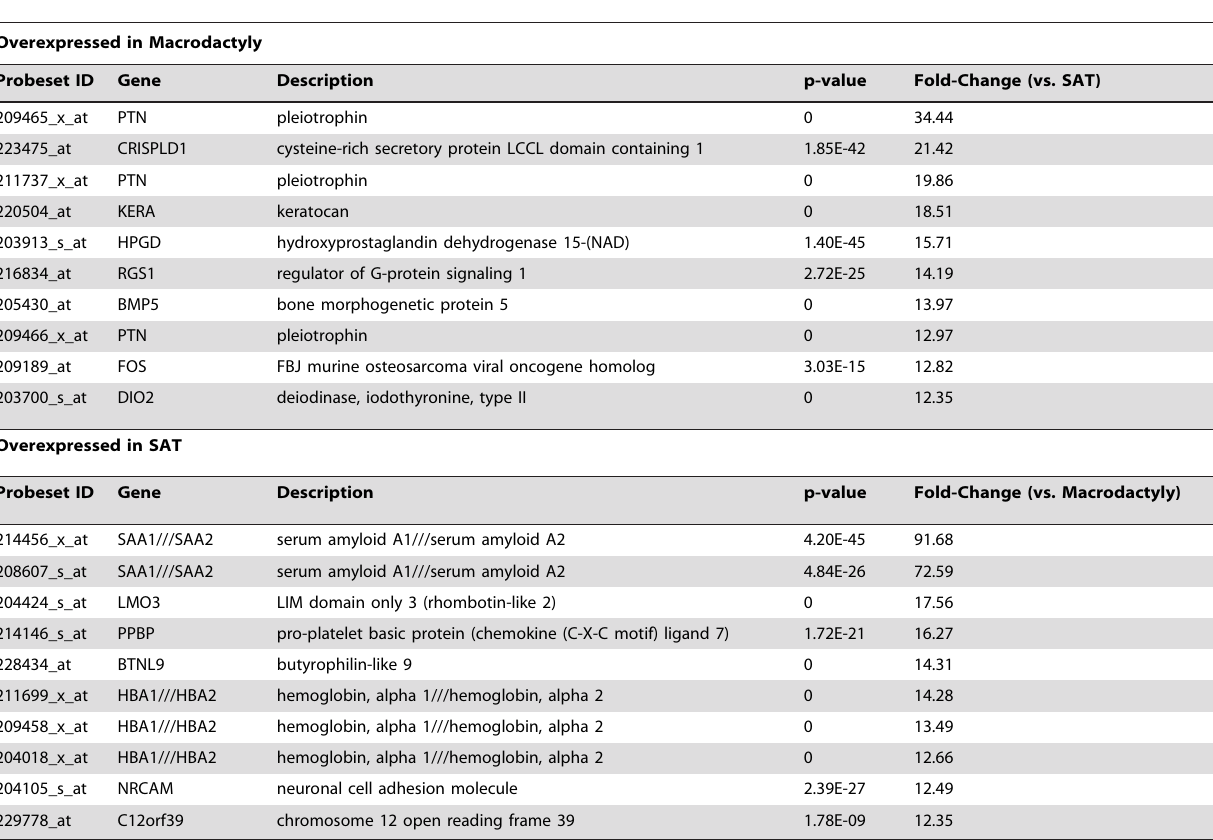
Table 1. Top 10 greatest fold-change probesets in macrodactyly and subcutaneous adipose tissue.